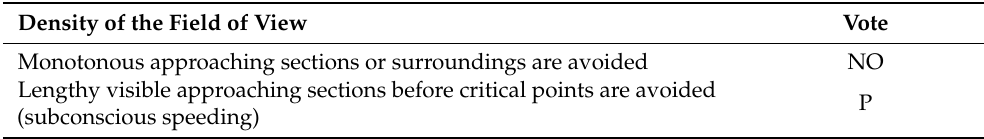
Table 7. Evaluations of the “density of the field of view” investigation topic. Density of the Field of View